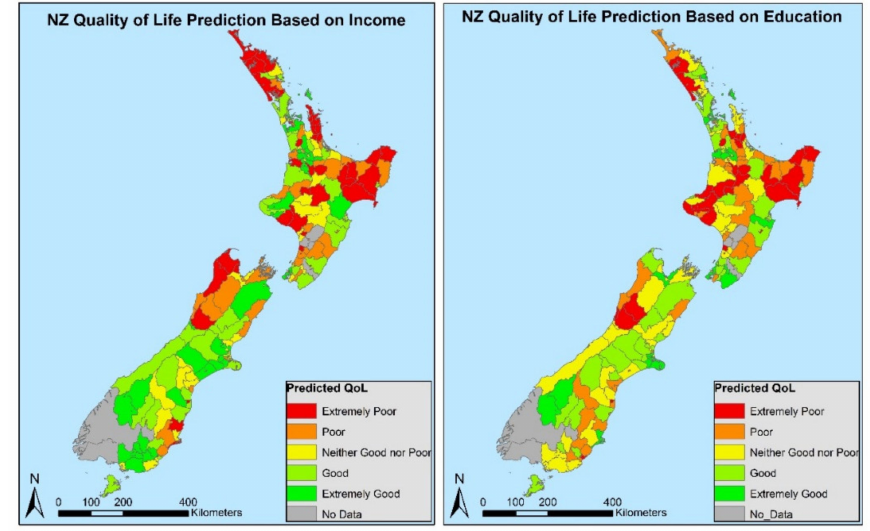
Figure 3. QoL prediction model for New Zealand based on income (left) and education (right). Source: own depiction based on 2013 NZ census